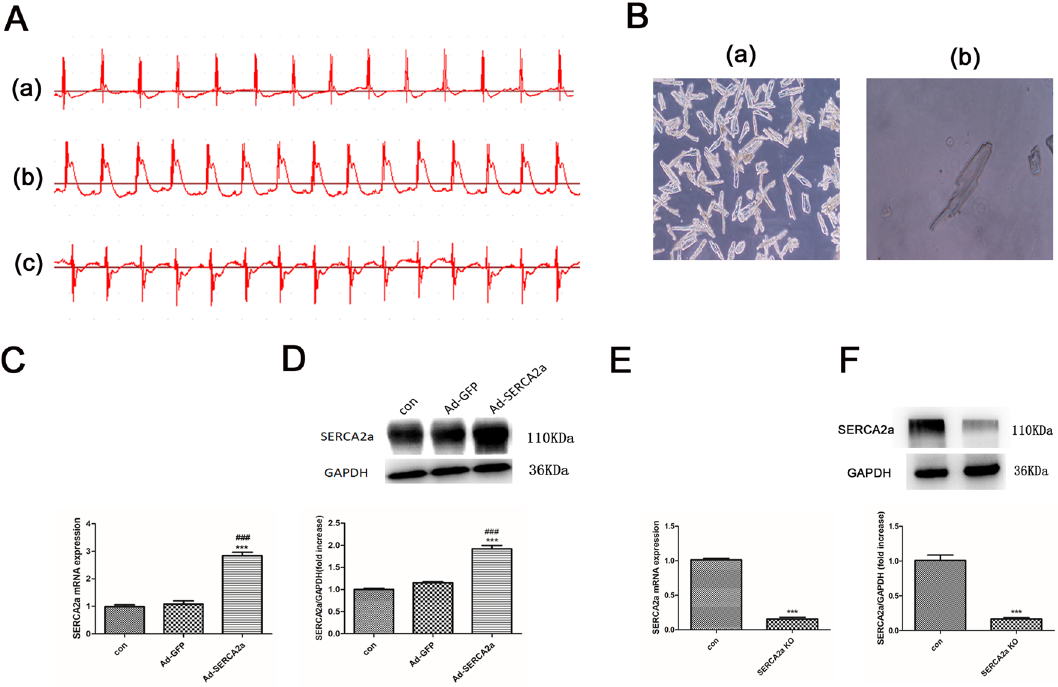
Figure 1. Electrocardiogram traces in myocardial I/R mice, isolated adult mice cardiomyocytes and the efficiency of SERCA2a overexpression and knockout. ( A ) Dynamic changes of electrocardiogram at different stages of myocardial I/R ((a) Basic state, (b) Ischemia state, (c) Reperfusion state). ( B ) Newly isolated adult mouse cardiomyocytes with different magnification ((a) 100 × , (b) 400 ×). ( C , E ) Expression of SERCA2a mRNA in each group. ( D , F ) The level of SERCA2a protein expression in each group. GAPDH was used as the internal control. The grouping of gels/blots cropped from different parts of the same gel. Uncropped blots are